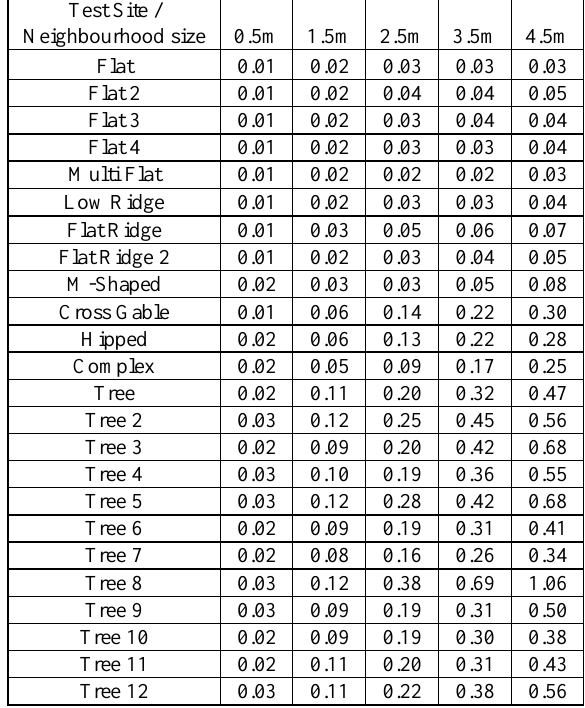
Table 3. Median Roughness (m) values for varying neighbourhood sizes for buildings and trees.